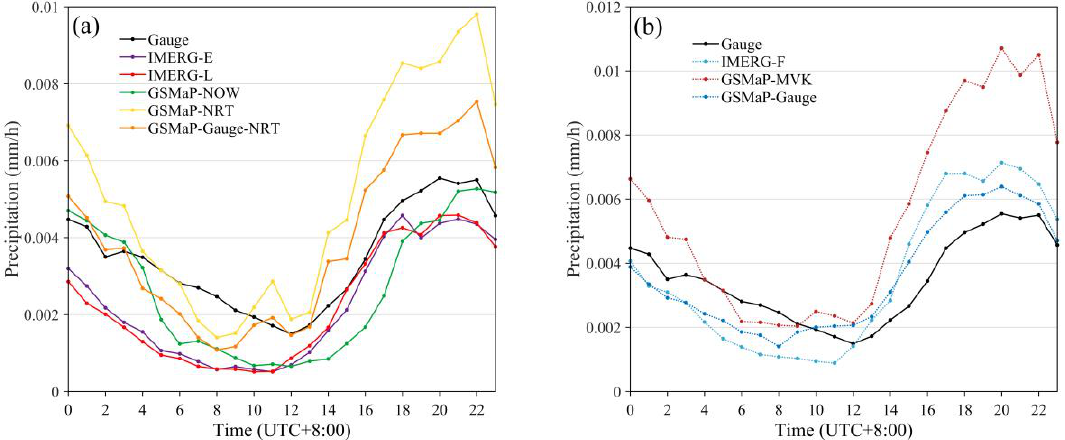
Figure 6. Comparison of diurnal cycles of the SPP-based precipitation estimates averaged at the locations of 13 rain gauges with the ground precipitation observations: ( a ) real-time and near-real-time SPPs and ( b ) post-real-time SPPs.